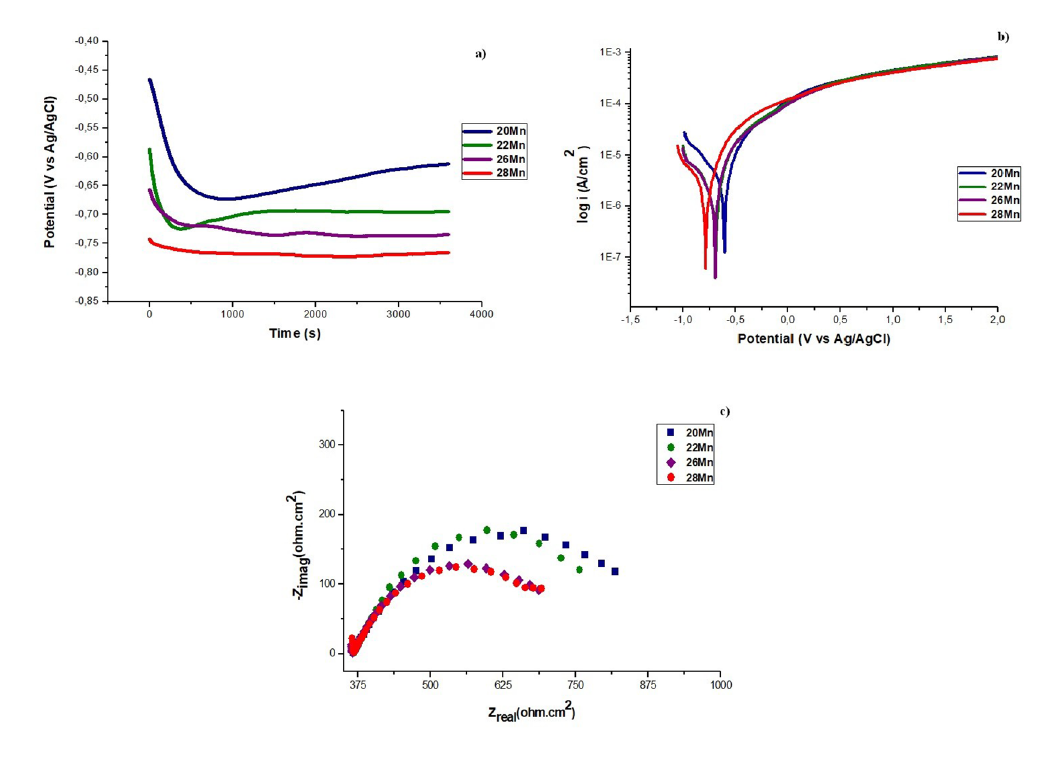
Figure 10. OCP (a) and linear polarization (b) curves of high manganese steels in aqueous solution of 0.1M de NaCl. Source: